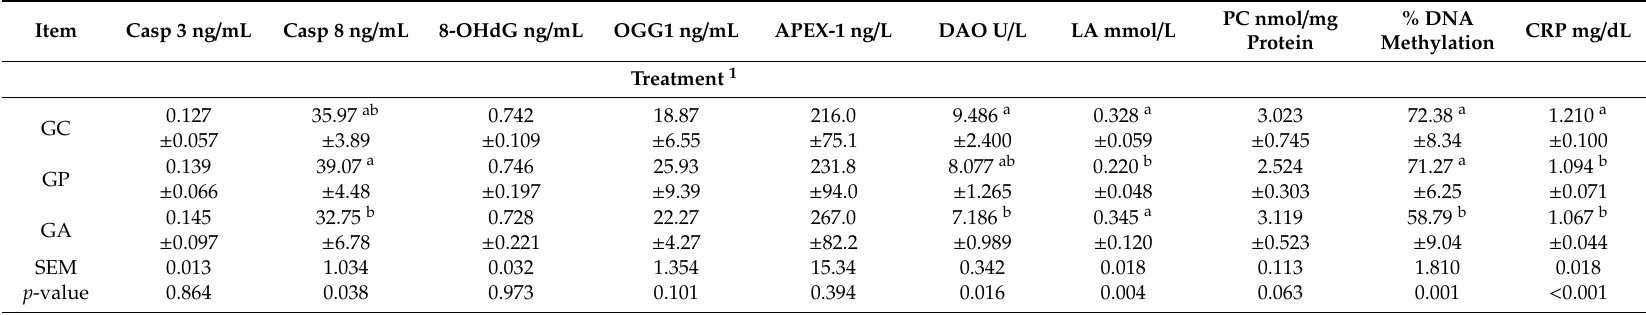
Table 2. Oxidative and epigenetic DNA damage and activity of repair enzymes in the blood of chickens (35 day of life).